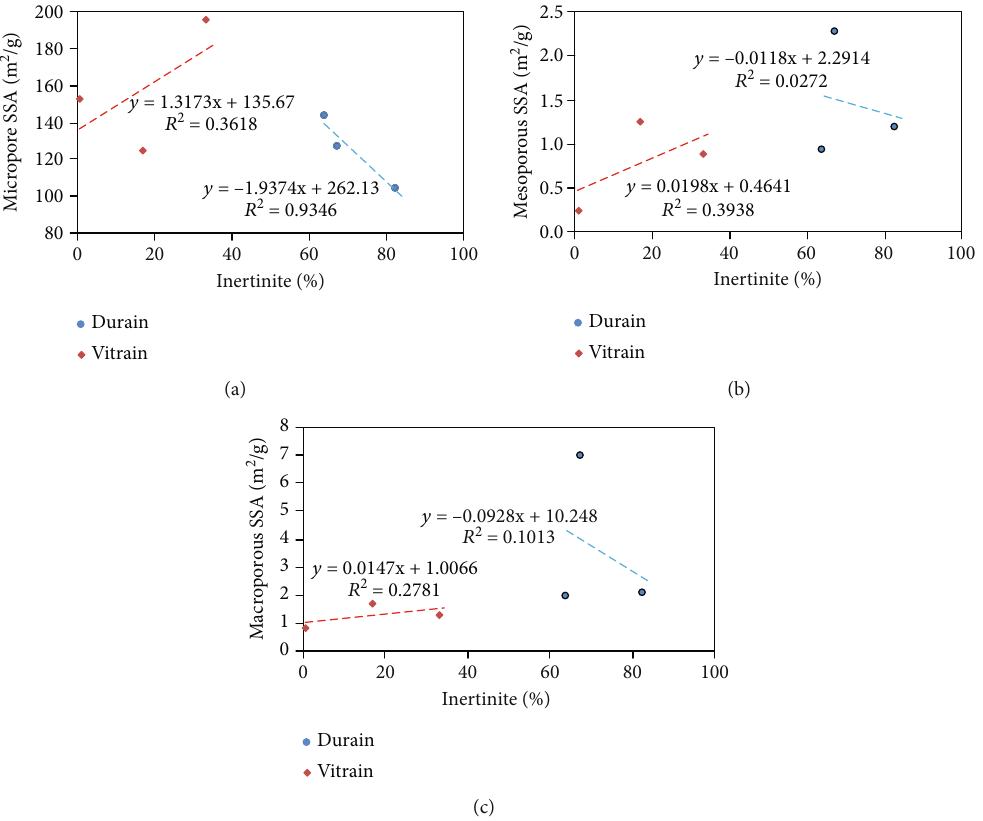
Figure 14: Correlation between inertinite content and SSA. (a) Micropore; (b) mesopore; (c)